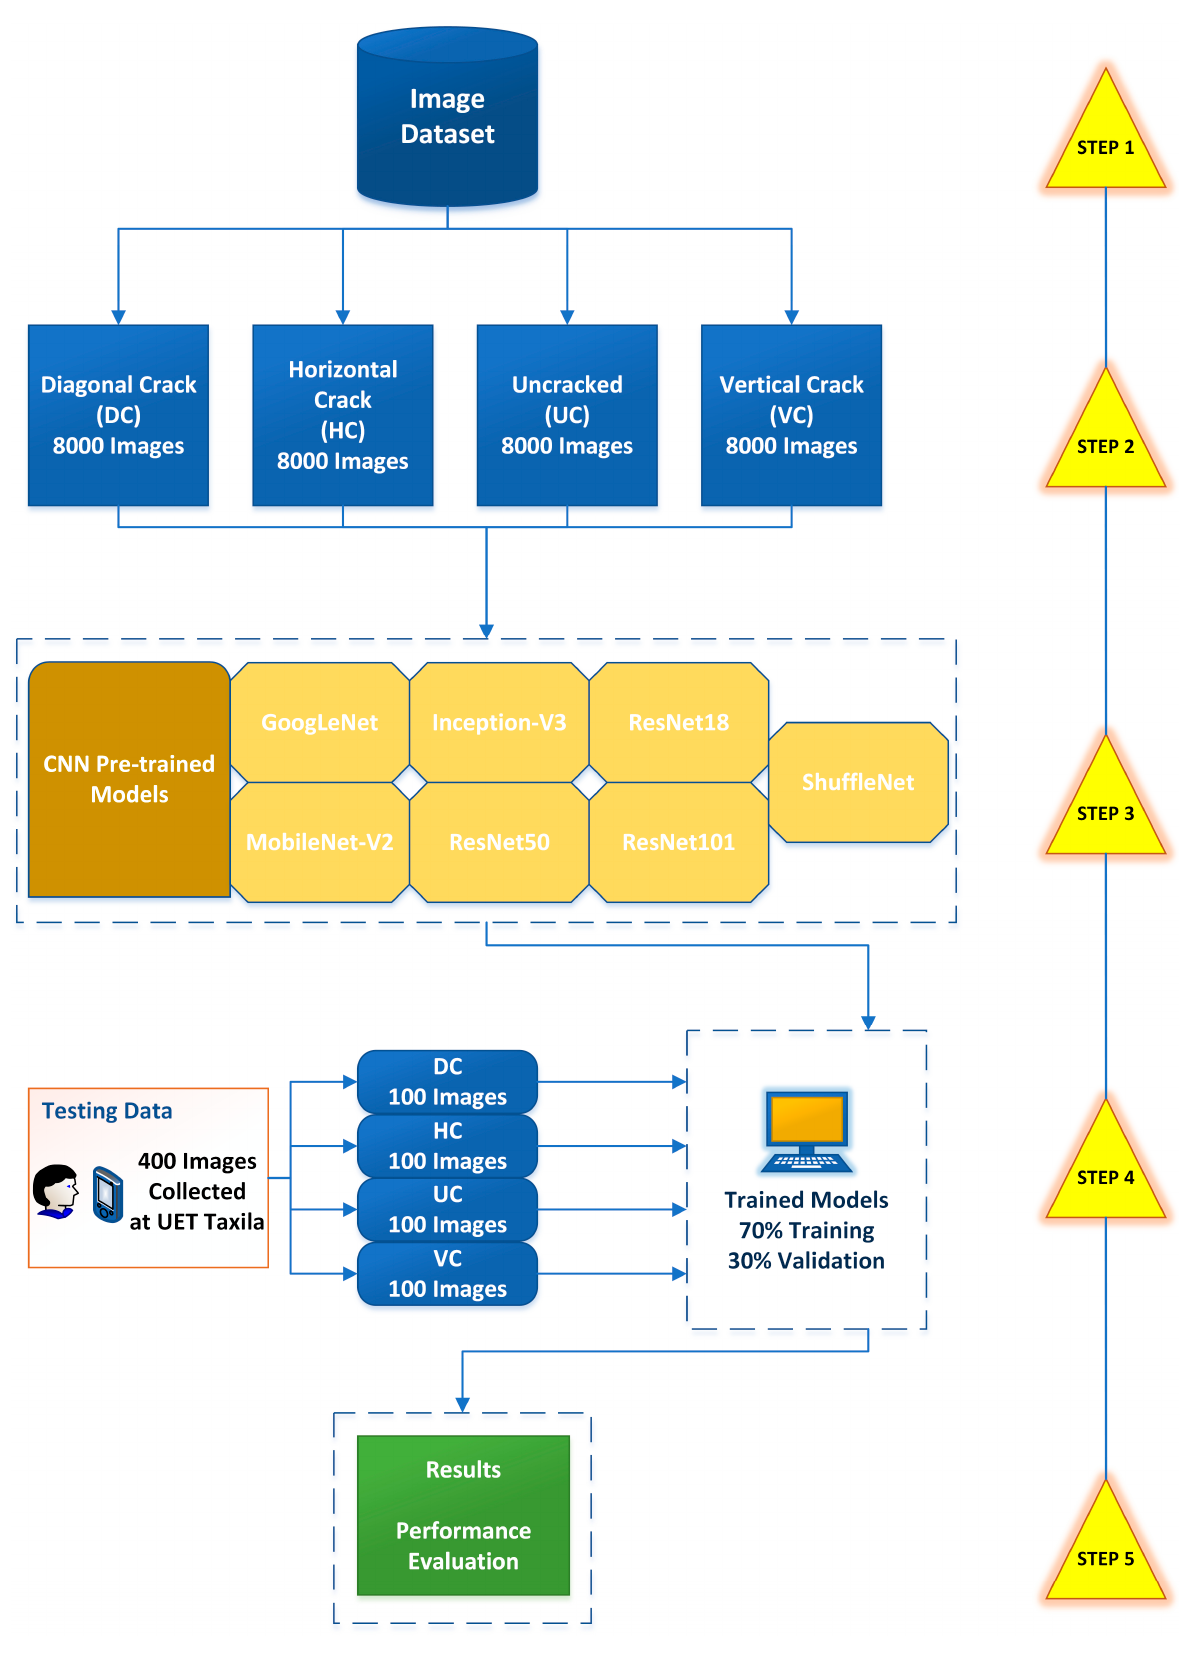
Figure 1. Proposed methodology.